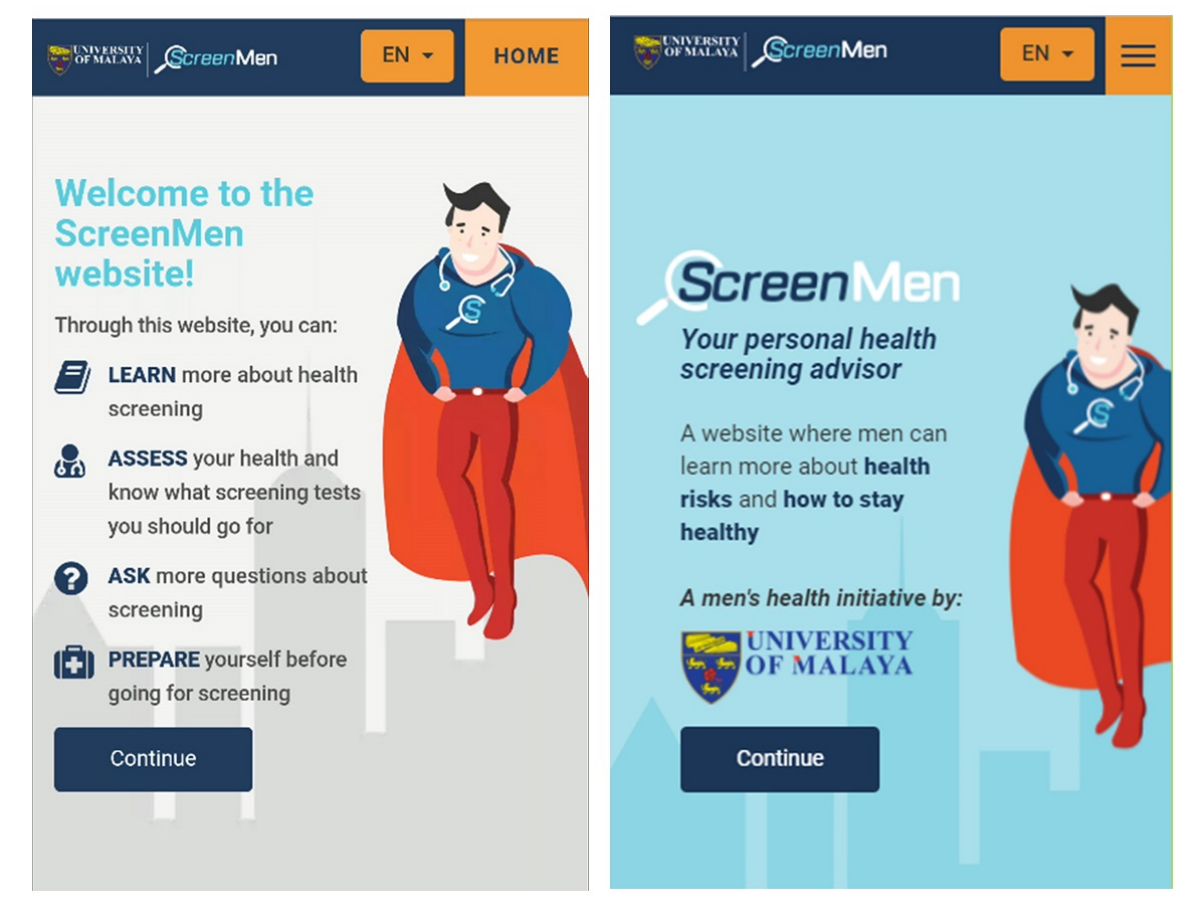
Figure 1. The home page of ScreenMen before and after